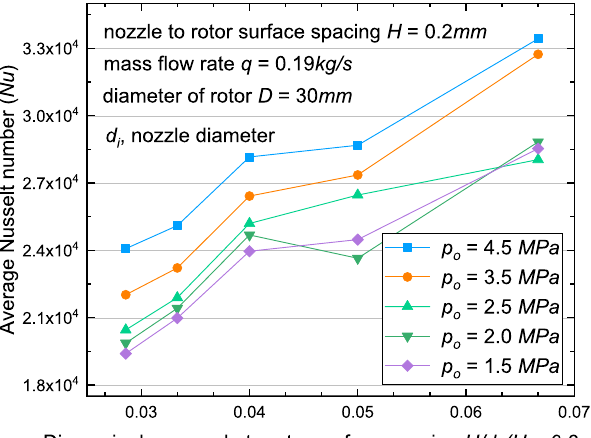
Fig. 9. Effect of H / d i ( H =0.2 mm) on the Nu with different outlet pressure p o .